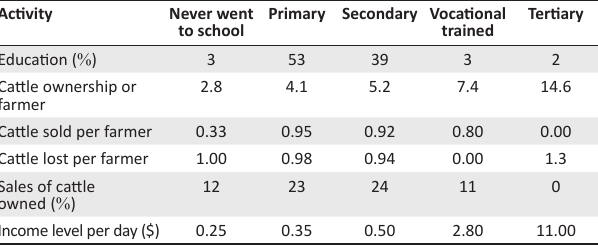
TABLE 1: Education, cattle sales, losses and income levels for cattle owners.